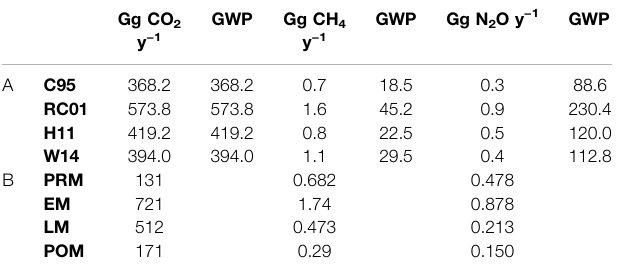
TABLE 2 | A. Annual emission estimation of air/water RAG emission with global warming potential and B. Seasonal emission estimate of air/water RAG emission integrated from the fl ux estimates calculated from four different parameterizations of gas transfer